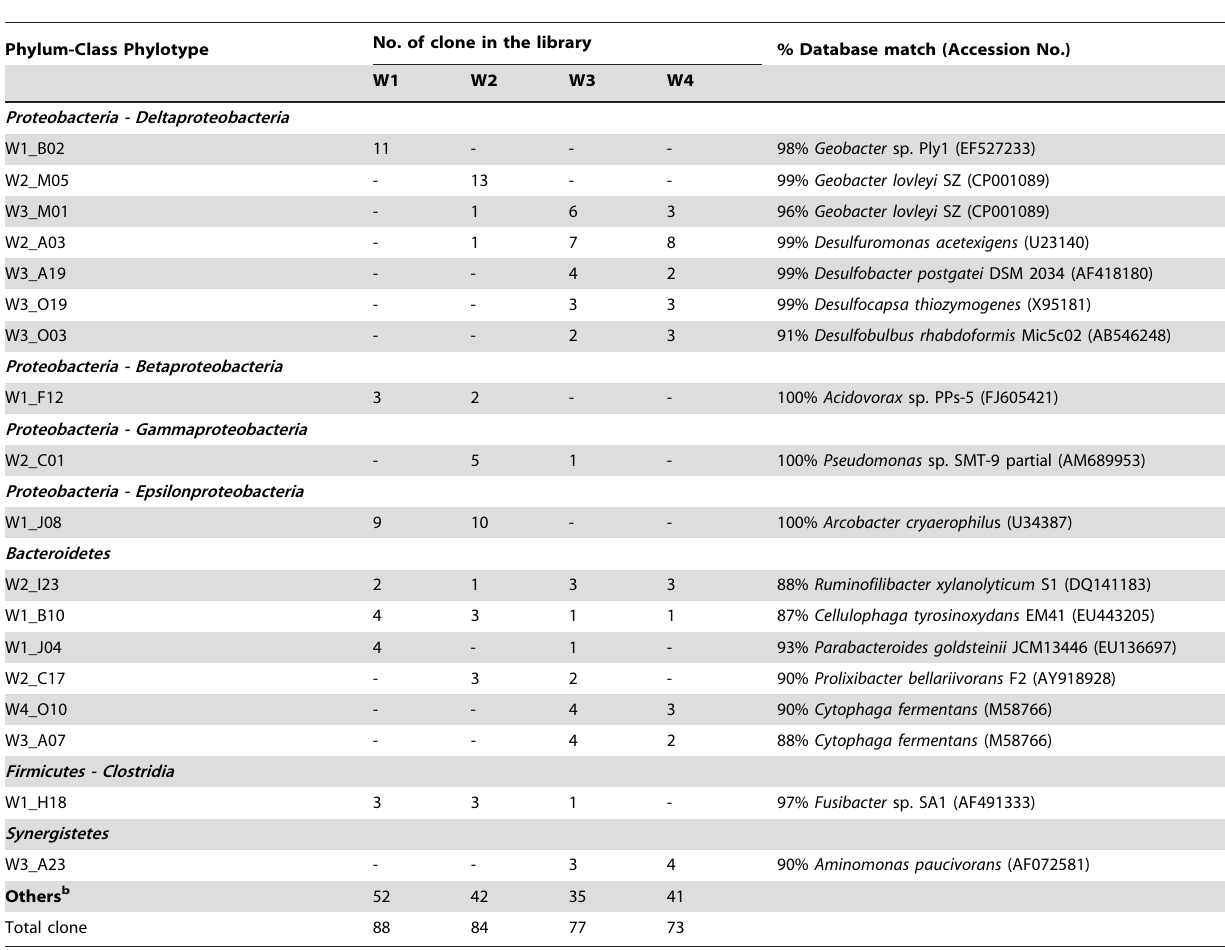
Table 3. Abundant phylotypes obtained from the enriched electricity-generating consortia a .